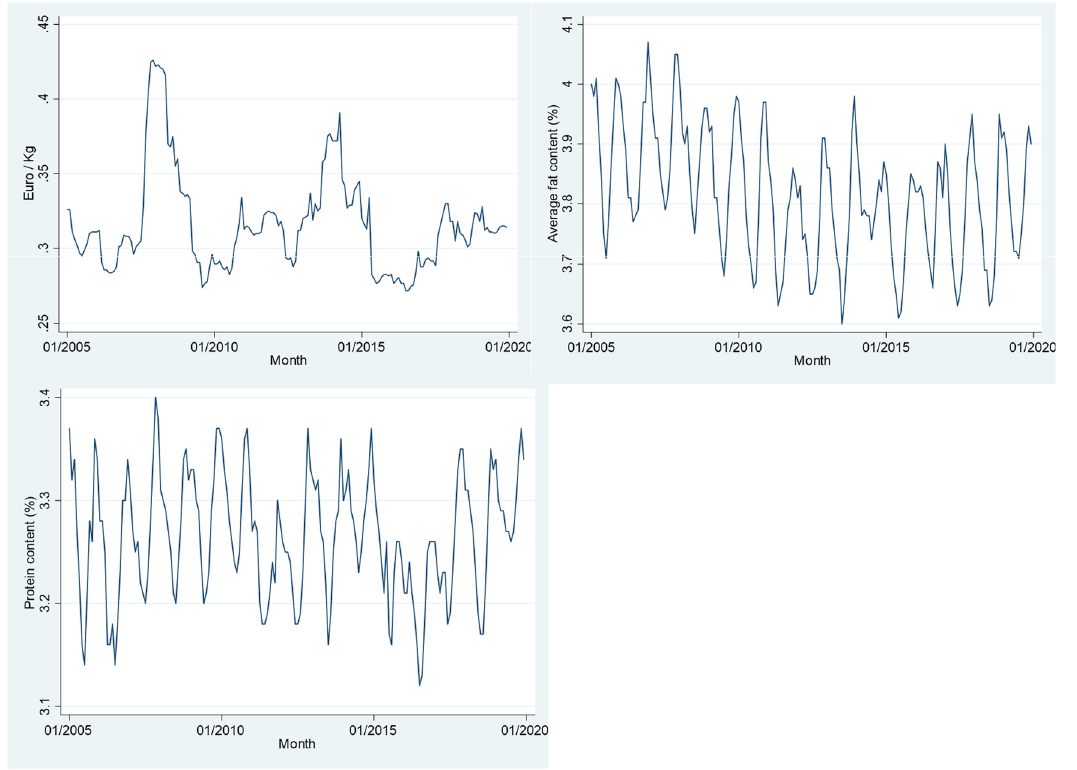
Figure 1: Average monthly prices and characteristics ( 2005 – 2019 ) in Portugal Mainland for milk purchased from individual